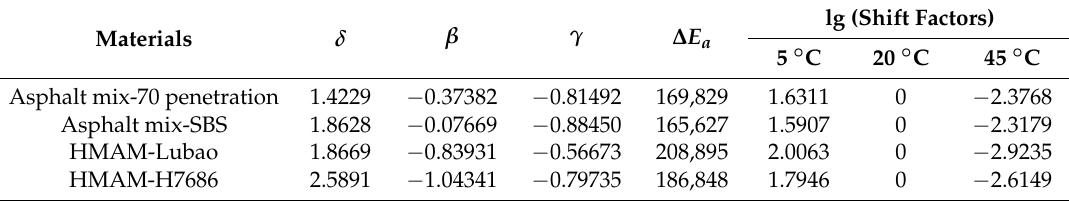
Table 8. Main parameters and shift factors of the master curves at reference temperature 20 ◦ C.